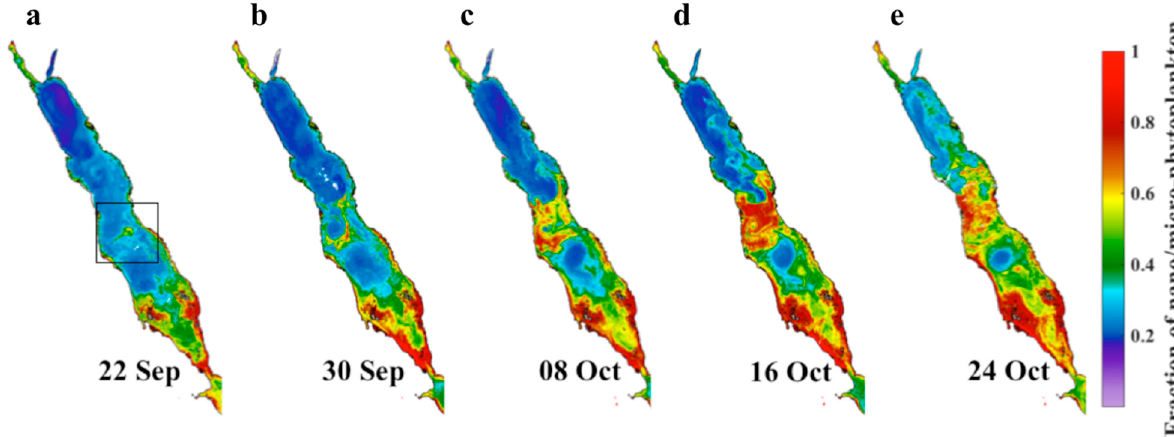
Figure 4. 8-day composites displaying the spatial distribution of the satellite-derived fractional contribution of nano/micro- phytoplankton ( F n,m ) to total Chl-a concentration. Panels ( a – e ) represent the development of F n,m between 22 September and 31 October